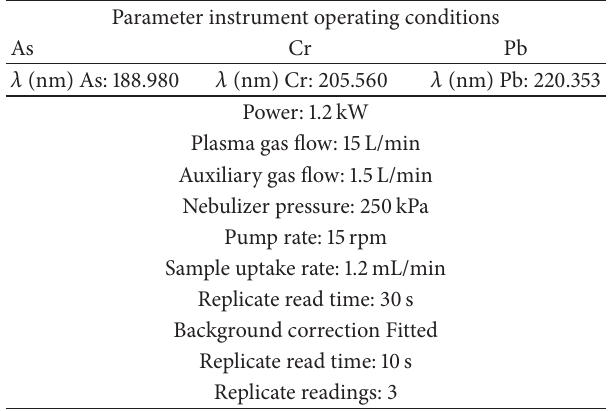
Table 1: The operating parameters of the system ICP-OES.